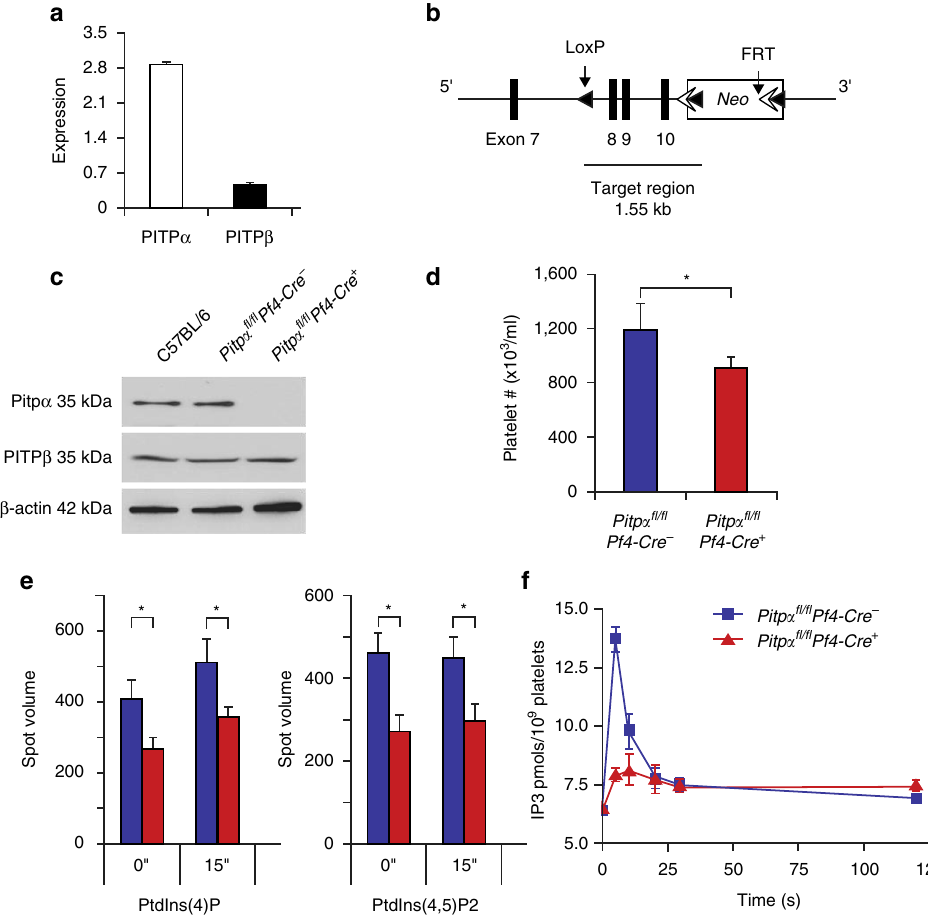
Fig. 1 PITP α mediates PtdIns synthesis and IP 3 production in mouse platelets. a Quanti fi cation of immunoblot demonstrates the types of class I PITP expressed in platelet lysates using isoform-speci fi c antibodies. Shown is the relative abundance of individual PITP isoforms in platelets from wild-type mice when normalized to recombinant PITP protein standards ( n = 3 mice per group; error bars are standard deviation (s.d.)). b Schematic representation of the conditional targeting strategy. Exons 8, 9, and 10 were targeted by the insertion of loxP recombination sites to generate Pitp α fl oxed alleles ( Pitp α fl / fl ). c Immunoblot of platelet lysate demonstrating the speci fi c deletion of the PITP α isoform in Pitp α fl / fl Pf4-Cre + platelets. d CBC analyses show decreased platelet count in Pitp α fl / fl Pf4-Cre + mice compared to their littermate controls ( n = 3 mice per group; error bars are s.d.; * p < 0.05, unpaired Student ’ s t -test). e PtdIns synthesis in thrombin-stimulated platelets derived from Pitp α fl / fl Pf4-Cre − and Pitp α fl / fl Pf4-Cre + mice. Pooled analysis of experiments shows the effect of the loss of PITP α on PtdIns(4)P and PtdIns(4,5)P 2 generation following thrombin stimulation at 1 U/ml ( n = 3 mice per group; error bars are s.d.; * p < 0.05, unpaired Student ’ s t -test). f The effect on IP 3 production by the loss of PITP α was analyzed. IP 3 production was impaired even at the earliest analyzed time point ( n = 3 mice per group; error bars are